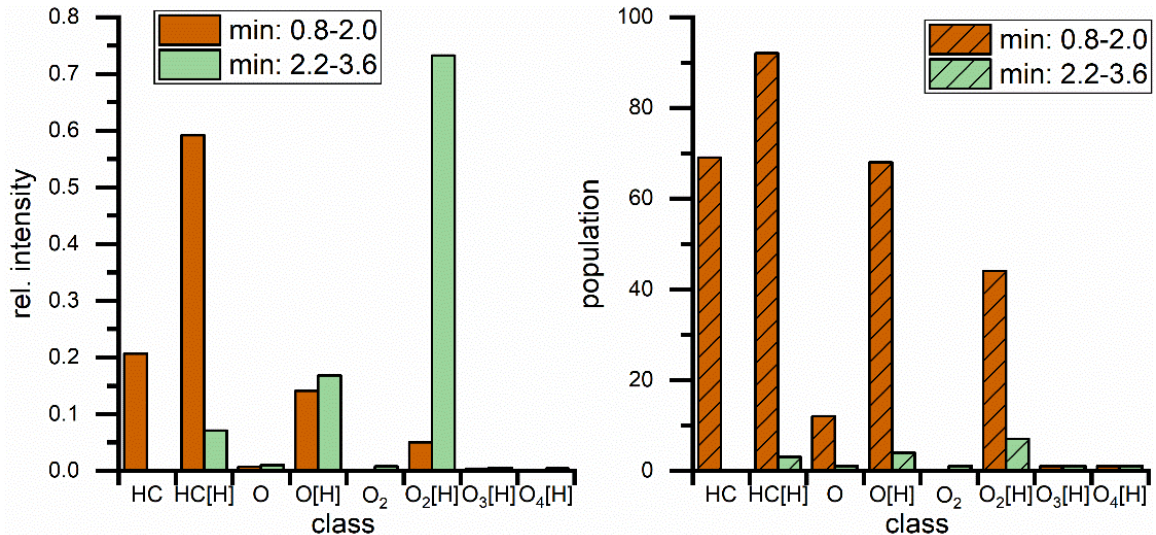
Figure 8. Comparison of major peaks in blend separation regarding class distribution for different hydrocarbon classes with rel. intensities ( left ) and population ( right ) which represents the number of identified compounds. Classes are describing hydrocarbons with different (amounts of) heteroatoms. Square brackets contain the adduct type, no brackets represents radical ions.